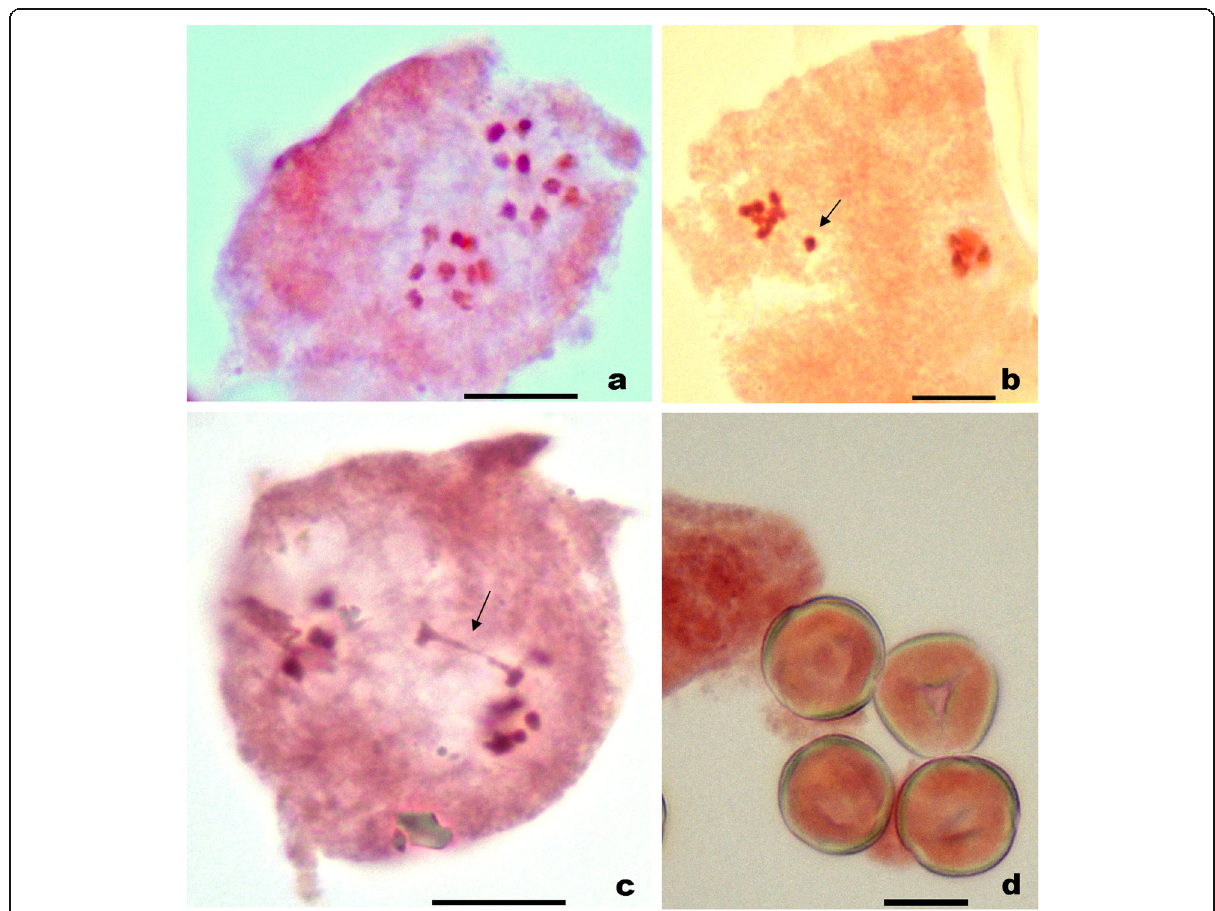
Fig. 2 Chromosomal study in Sophora mollis . a A pollen mother cell showing n =9 at metaphase-II, ( b ) lagging of chromosome at anaphase-I (arrowed), ( c ) non-disjunction of chromatin material at anaphase-I (arrowed), ( d ) apparently fertile/stained pollen grains. Scale =10 μ